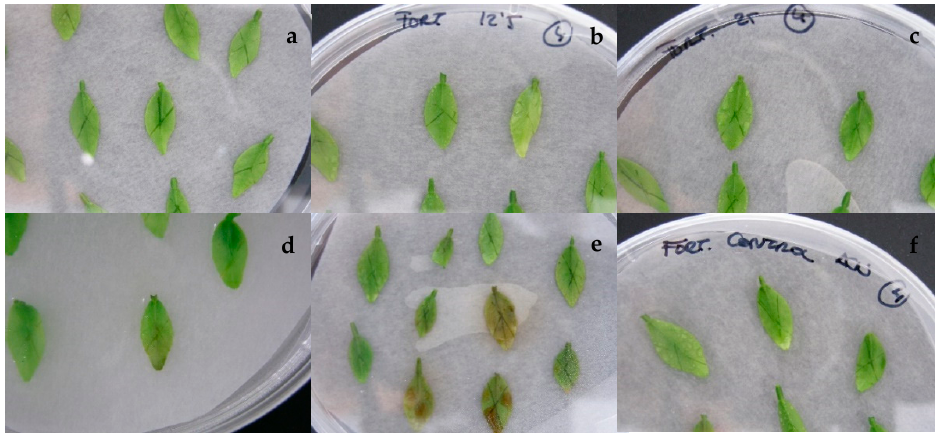
Figure 3. Excised and wounded leaves of the mandarin ‘Fortune’ exposed to 0 ( a ), 12.5 ( b ), 25 ( c ), 50 ( d ), and 75 ( e ) mg L − 1 of Alternaria citri toxin and acetonitrile ( f ).